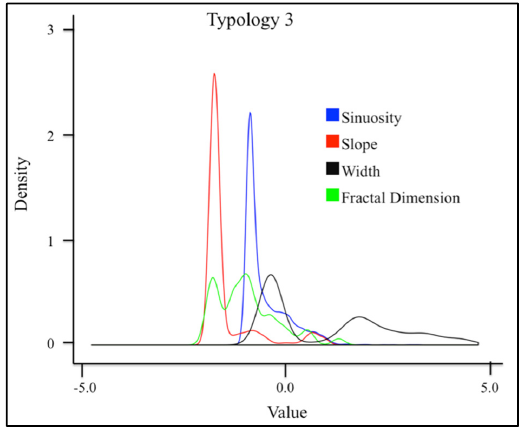
Figure 5. Density plot of the normalized values of channel sinuosity, slope, fractal dimension, and width for Typology 3. Table 2. Qualitative contribution of variables to each typology derived from the Principal Component Analysis. ( − is a negative relationship, + is a positive relationship, 0 is no discernable relationship).